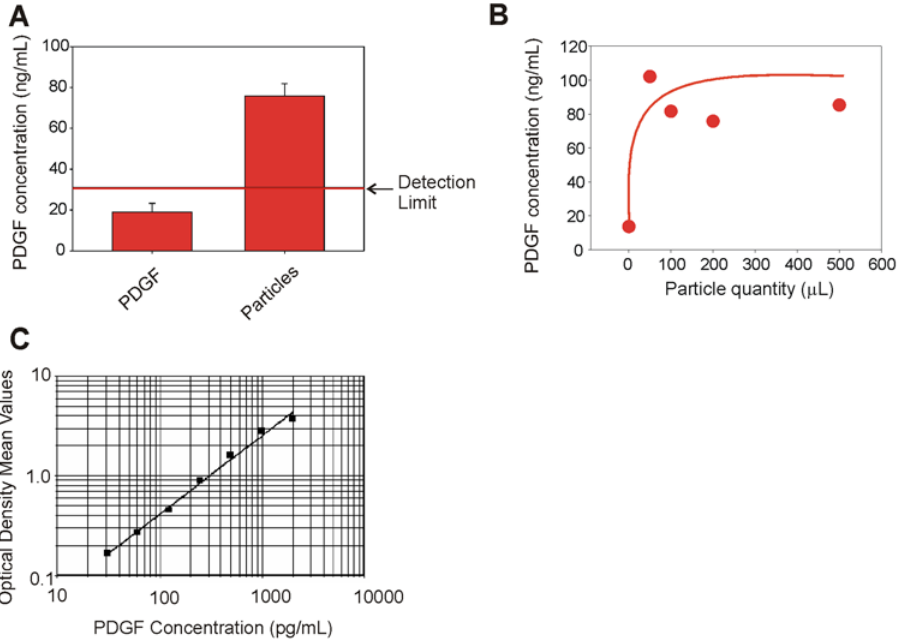
Figure 5. Core shell particles raise the concentration of undetectable PDGF into the detection range of ELISA assay. (A) ELISA readings of the starting solution of PDGF in Calibrator diluent RD6-3 (R&D Systems, animal serum with preservatives) at a concentration of 18.92 + / 2 4.313 pg/ mL and PDGF eluted from core-shell particles (85.27 + / 2 2.24 pg/mL). (B) PDGF concentration in the core-shell particle eluate plotted against the quantity of particles utilized for the incubation, duplicate experiments. (C) ELISA standard curve of PDGF concentration versus absorbance. The standard curve was generated with two repeats for each PDGF calibrator concentration.